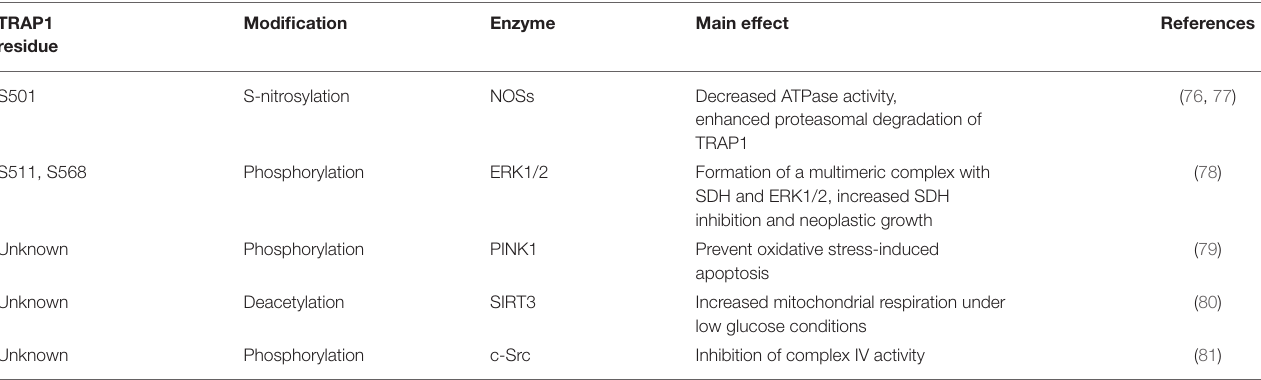
TABLE 2 | Reported post-translational modifications of